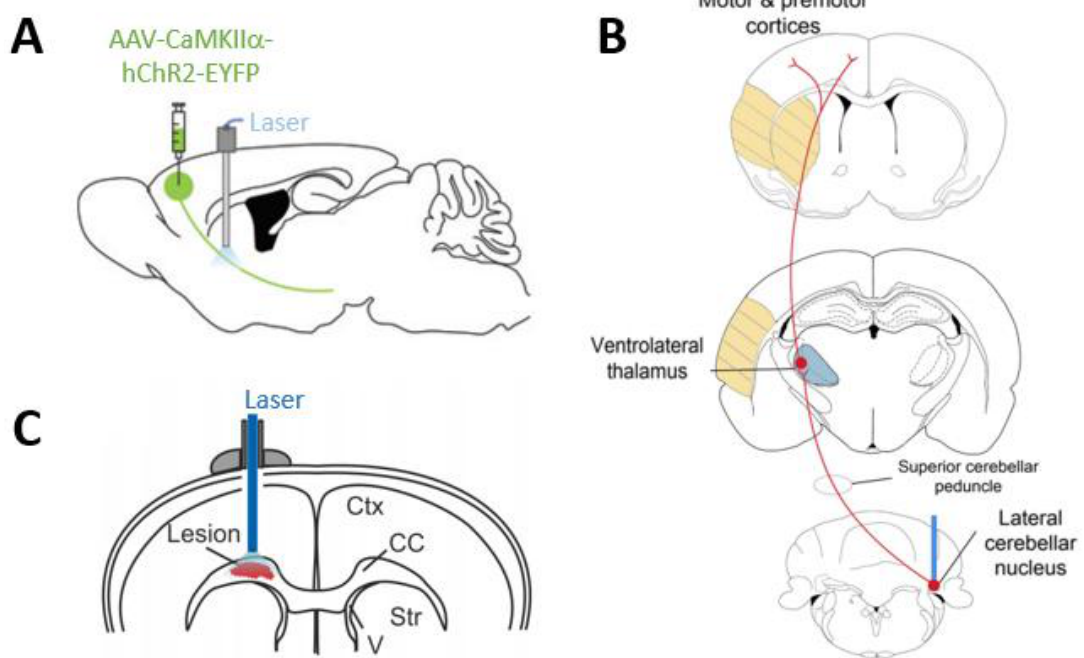
Figure 4. Representative schemes of optogenetic therapeutic pre-clinical application in Parkinson’s, stroke, and multiple sclerosis. ( A ) Experimental scheme: ChR2 is expressed into the M2 area (green) and optical fibre (blue) is implanted over the dorsomedial striatum. Adapted from [115]. ( B ) Diagram showing the dentato-thalamo-cortical pathway stimulated (from the bottom to the top). Fibre cannula is implanted in the contralesional lateral cerebellar nucleus (LCN–bottom). The region of the yellow hatch marks represents the infarct areas (striatum and cortex). Adapted from [116]. ( C ) Scheme showing optogenetic neuronal stimulation of the lateral corpus callosum (CC). The optic fibre is placed above the demyelinated lesions (in red) to stimulate axonal projection of neocortex neurons. Abbreviations: Ctx, cortex; Str, striatum; V, ventricle. Adapted with permission of American Society for Clinical Investigation from [117].